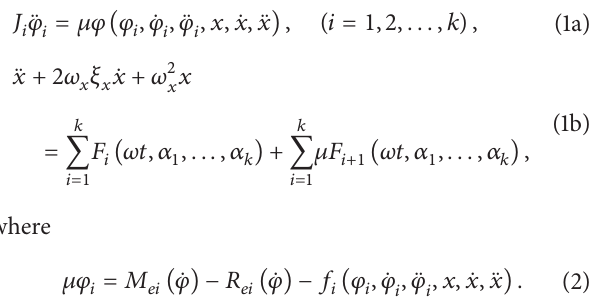
Figure 1 in practical industrial application. Two motors rotate in same direction connected with the coupling unit, which consists of a connecting rod, chutes, coupling springs, and slide blocks. The chute, linked to the ends of the connecting rod by welding, should be mutually paralleled. The slide block and the coupling springs are installed in the chutes. Besides, the stiffness of the connecting rod is bigger than the coupling spring and the connecting rod with smaller density. Figure 2 describes the dynamics model of the vibration system, which mainly consists of a rigid vibrobody 𝑚 0 [kg], two motors 𝑚 𝑖 [kg] (for 𝑖 = 1, 2 ), and the coupling unit. The two unbalanced rotors are driven by two induction motors. The vibratory body is connected with an elastic foundation through some stronger stiffness springs 𝑘 𝑥 , 𝑘 𝑦 , 𝑘 𝜓 [N/m] in 𝑥 - , 𝑦 - , 𝜓 -directions, which have negative effects on the movement with damping constant 𝐶 𝑥 , 𝐶 𝑦 , 𝐶 𝜓 [N ⋅ s/m]. Con- sidering the unbalanced rotor as a point mass, the distance between the rotor and its own spin axes ( 𝑜 𝑖 ) is denoted by 𝑟 𝑖 [m]. The coupling unit is simplified as a linear spring 𝑘